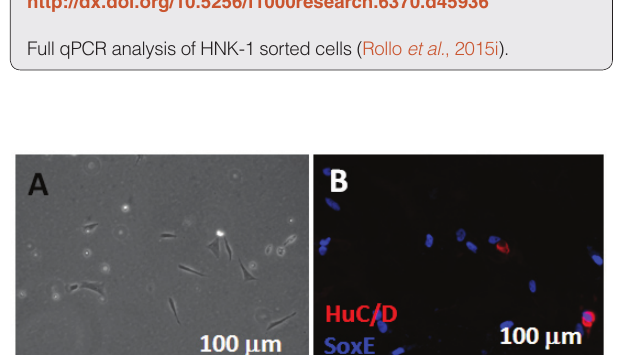
Dataset 10. Raw data for Supplemental Figure